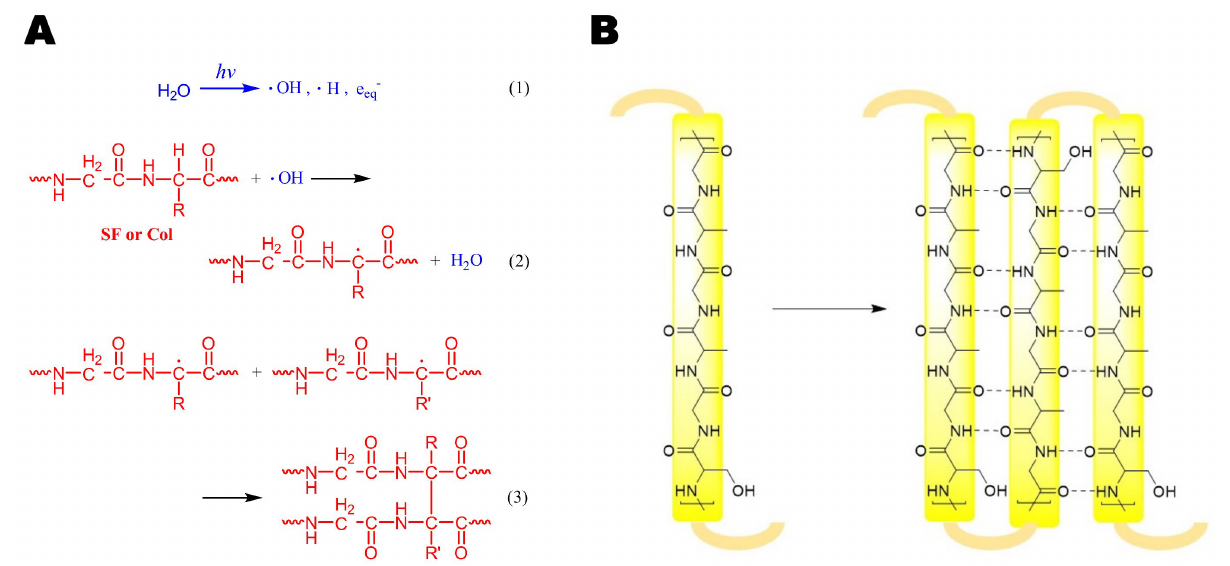
Figure 2. Mechanism of the γ -ray and ethanol crosslinking of SF-ECM hydrogel. ( A ). Mechanism of the γ -ray crosslinking. Active groups such as hydroxyl radicals were first generated from water by irradiation (1), after which polypeptide chains were attacked and turned to radicals (2). These peptide radicals could finally combine to form a crosslinking network (3). ( B ). Mechanism of ethanol crosslinking. The treatment of ethanol induces a conformation change of the SF and dECM polypeptide chain. Basically, neighboring repeating sequences of GAGAGS align together to form hydrogen (Figure 2B), which corresponds to better mechanical properties of the